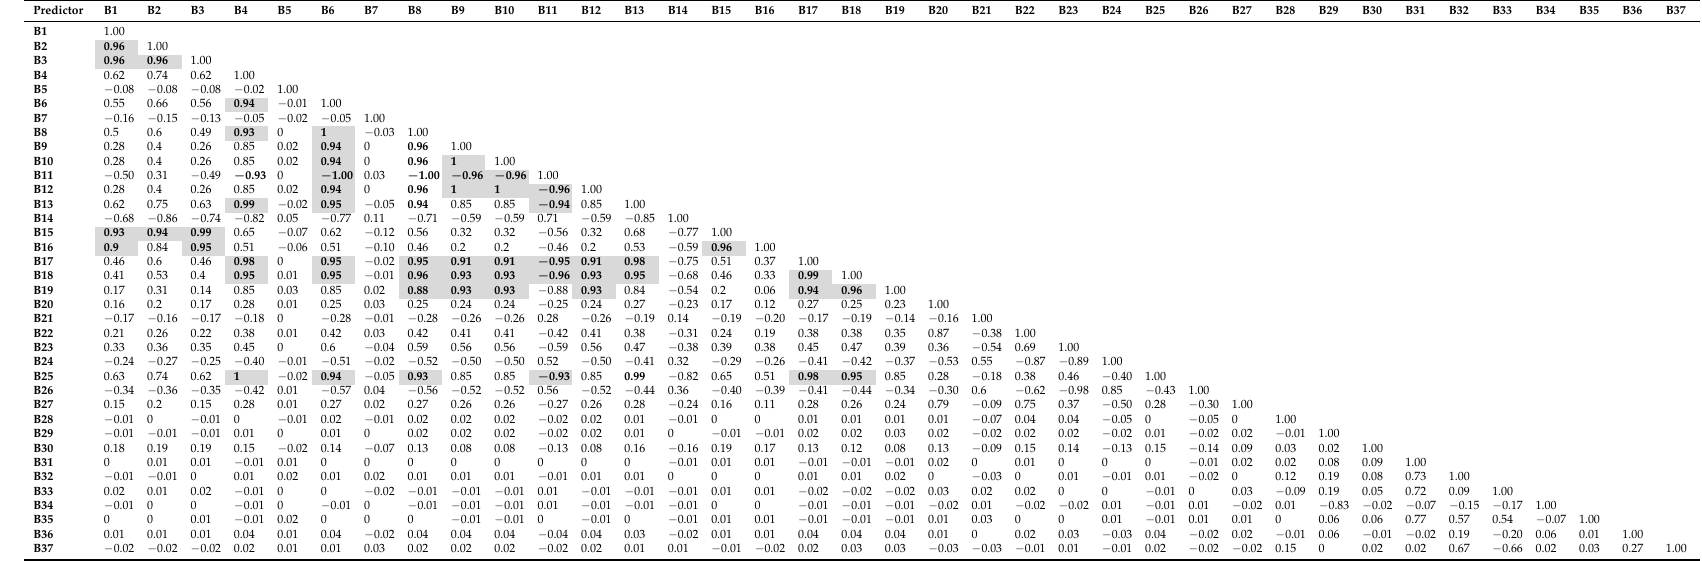
Table 2. Correlation matrix of predictor variables. Linear correlations (|r| ≥ 0.89) are shaded grey. Quickbird bands 1–4 are designed B1–4; see text for additional